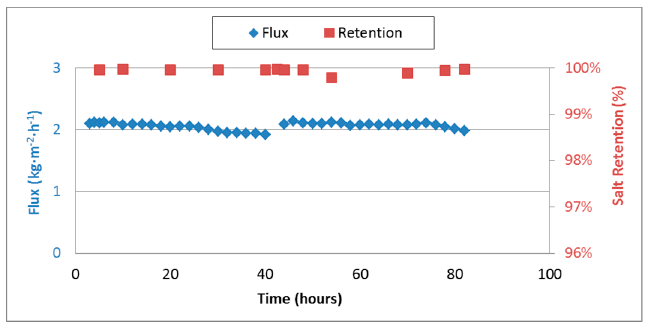
Figure 9. Long term experiment of membrane 6, T f = 45 °C, T p = 40 °C, v = 0.13 m·s − 1 , NaCl concentration = 35 g·L − 1 .